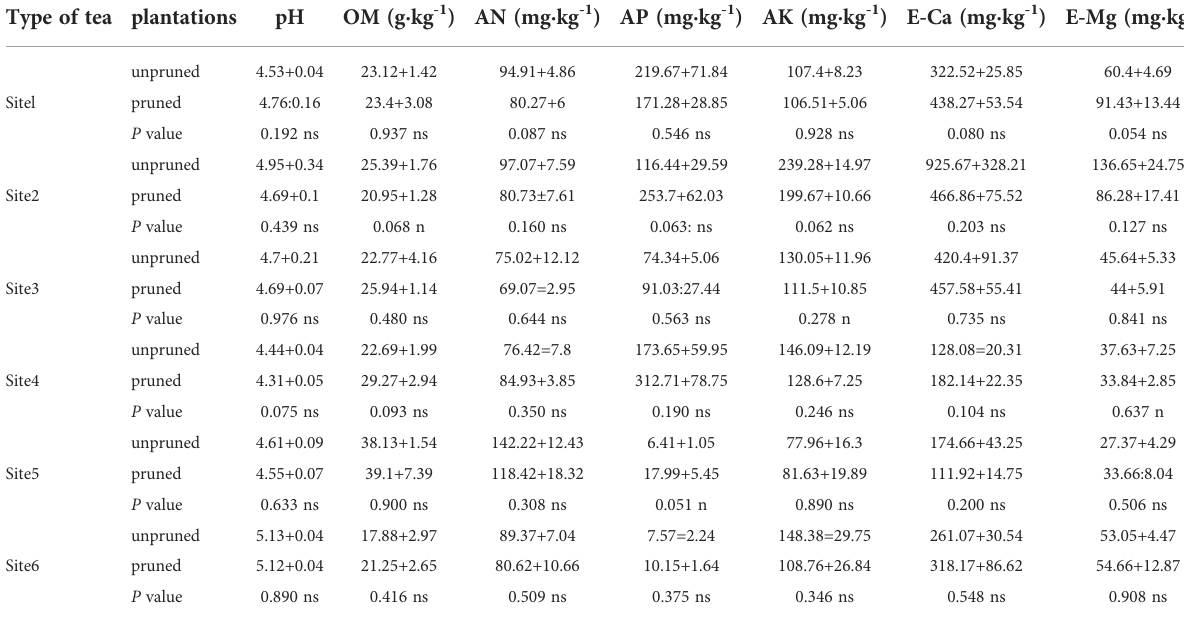
TABLE 2 Soil fertility properties of tea plantations in representative